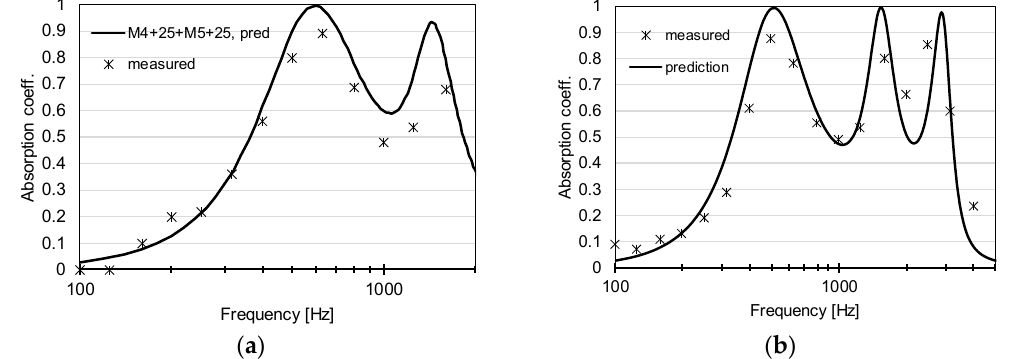
Figure 7. Comparison of the predicted and measured sound absorption coefficients for ( a ) double-membrane structure: micro-perforated membrane M4 followed by a 25 mm cavity combined with M5 followed by a 25 mm cavity. ( b ) triple-membrane structure: panel D, 10 mm cavity, micro-perforated membrane M4 followed by a 15 mm cavity, combined with M5 followed by a 30 mm cavity.